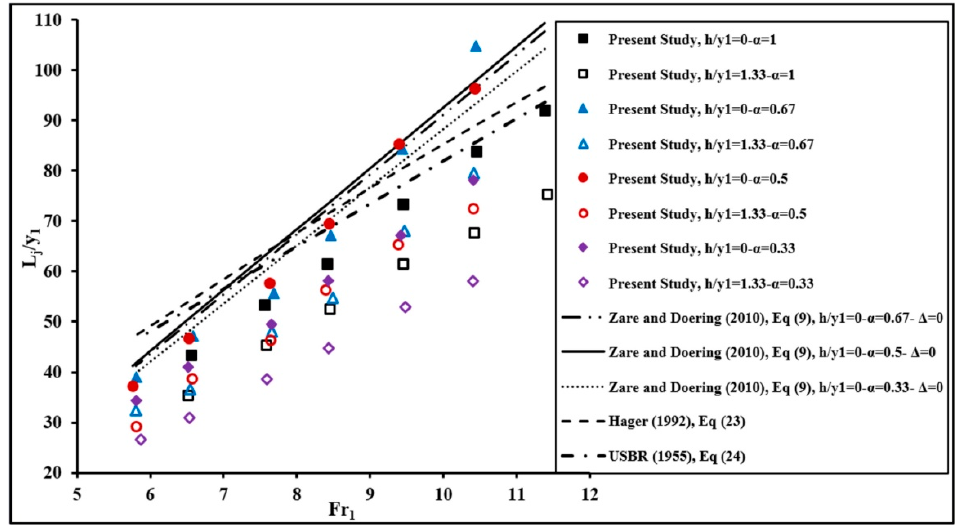
Figure 11. Relative length of the hydraulic jump as a function of upstream Froude number for di ff erent expansion ratios ( α = 0.33, 0.5, 0.67, 1) with asymmetry ratio ∆ = 0.16 on smooth and rough bed ( h / y 1 = 1.33).